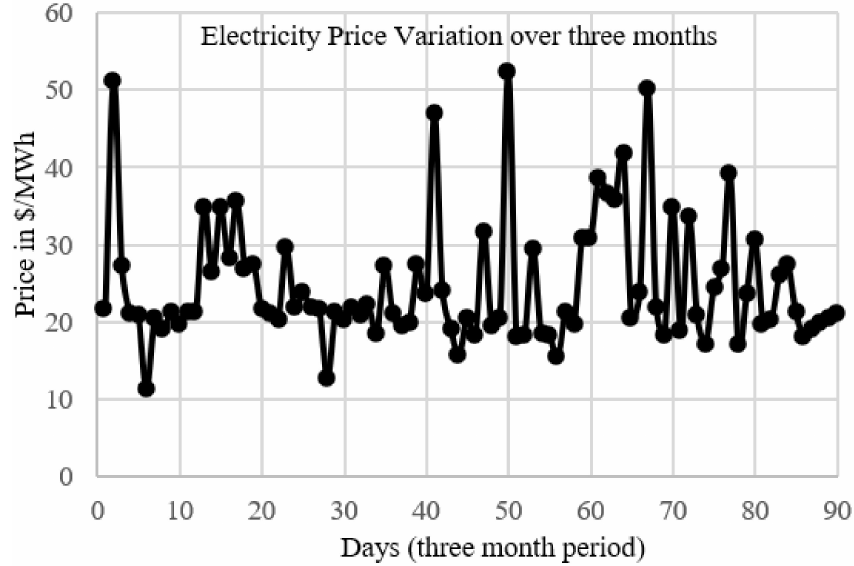
Figure 5. Variation of settlement point price over three